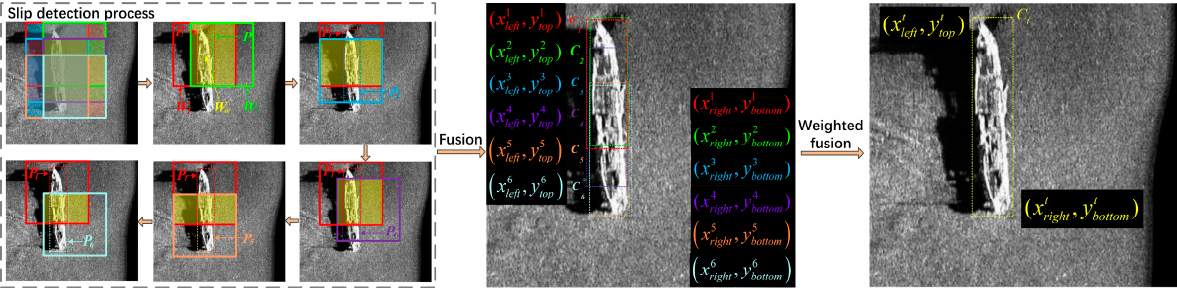
Figure 12. Confidence-based weighted fusion strategy flowchart.